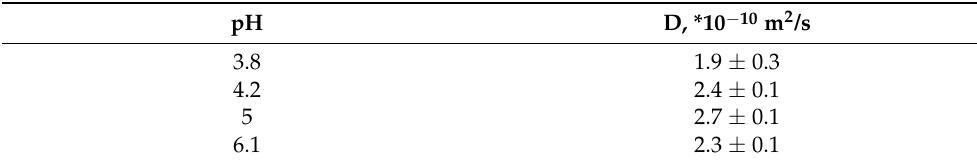
Table 1. Diffusion coefficients (D) of GA protons in the mixtures of nifedipine + GA for samples with different pH and 1mM of